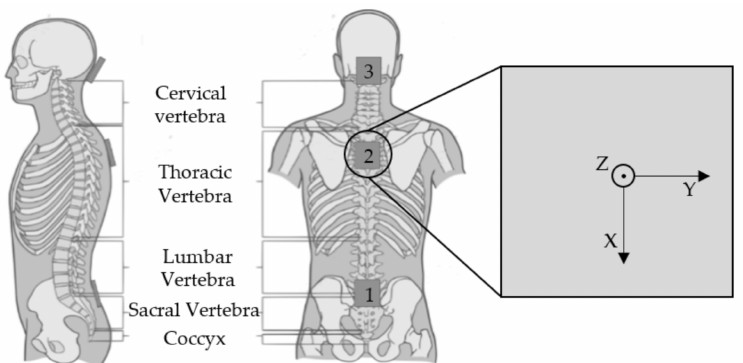
Figure 1. Positioning of the sensors: ( 1 ) between the fifth lumbar-vertebra (L5) and the first sacral- vertebra (S1), ( 2 ) at the transition from thoracic- to cervical-vertebra (Th1, C7) and ( 3 ) on the back of the head. On the right, the axes of the sensors are